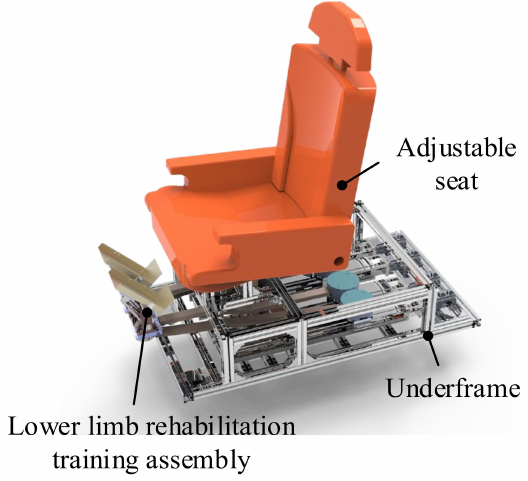
Figure 3. The overall structure of